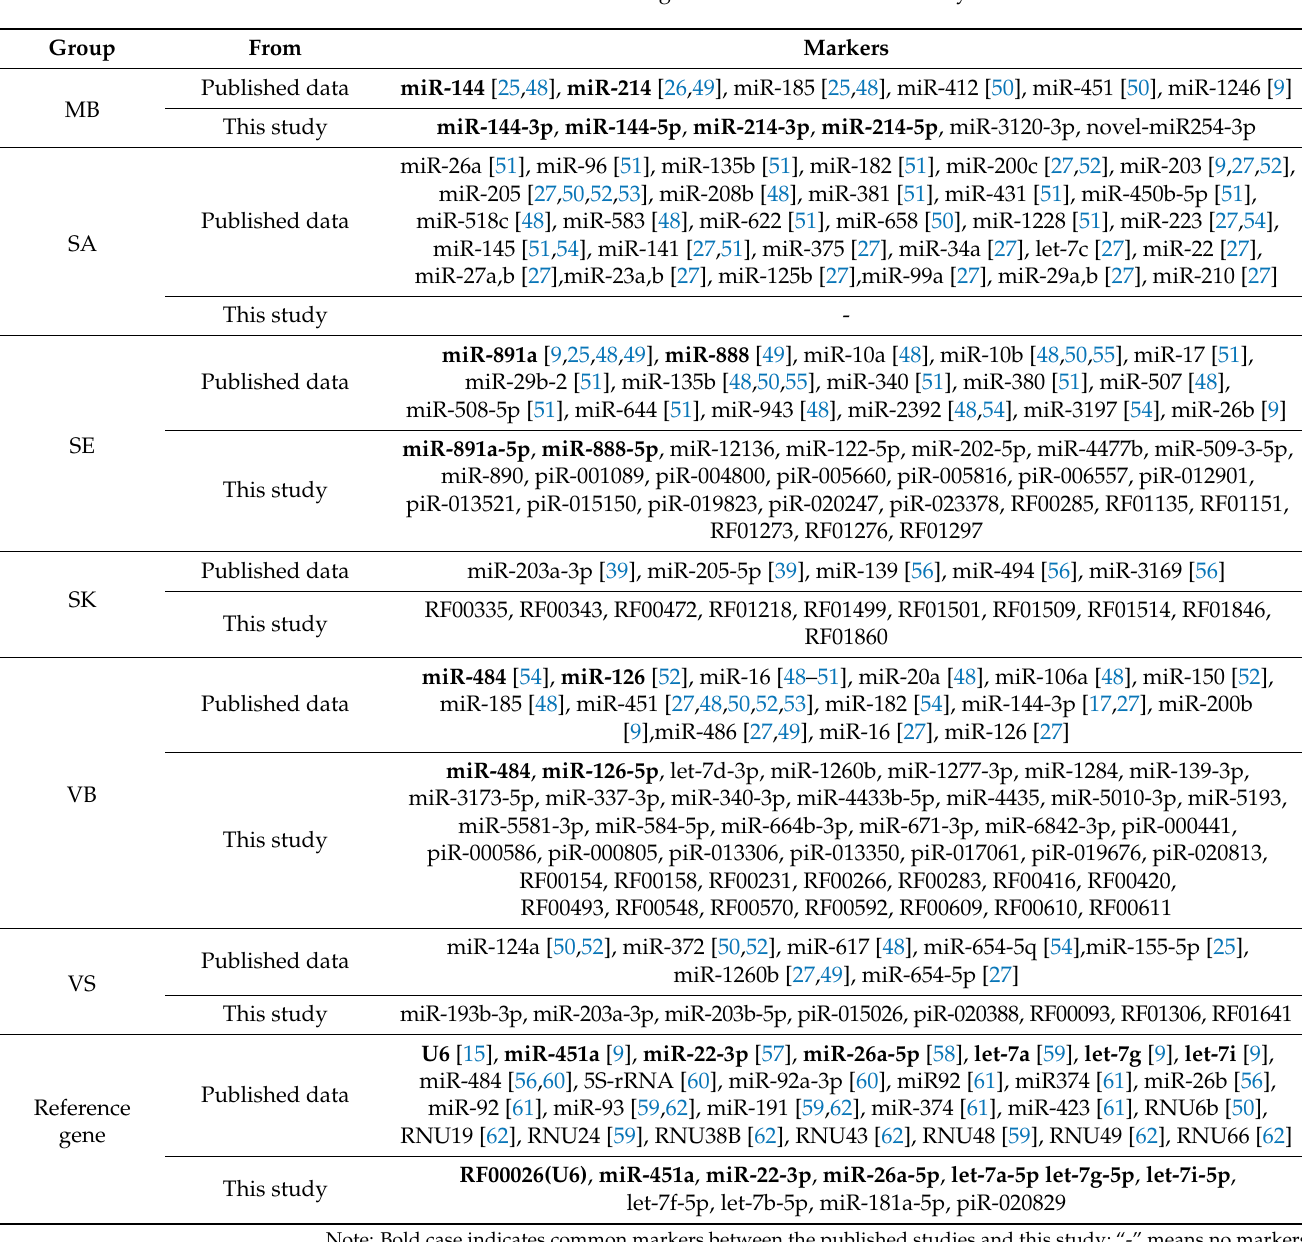
Table 2. The ASMs and reference genes screened in the five body fluids and one skin